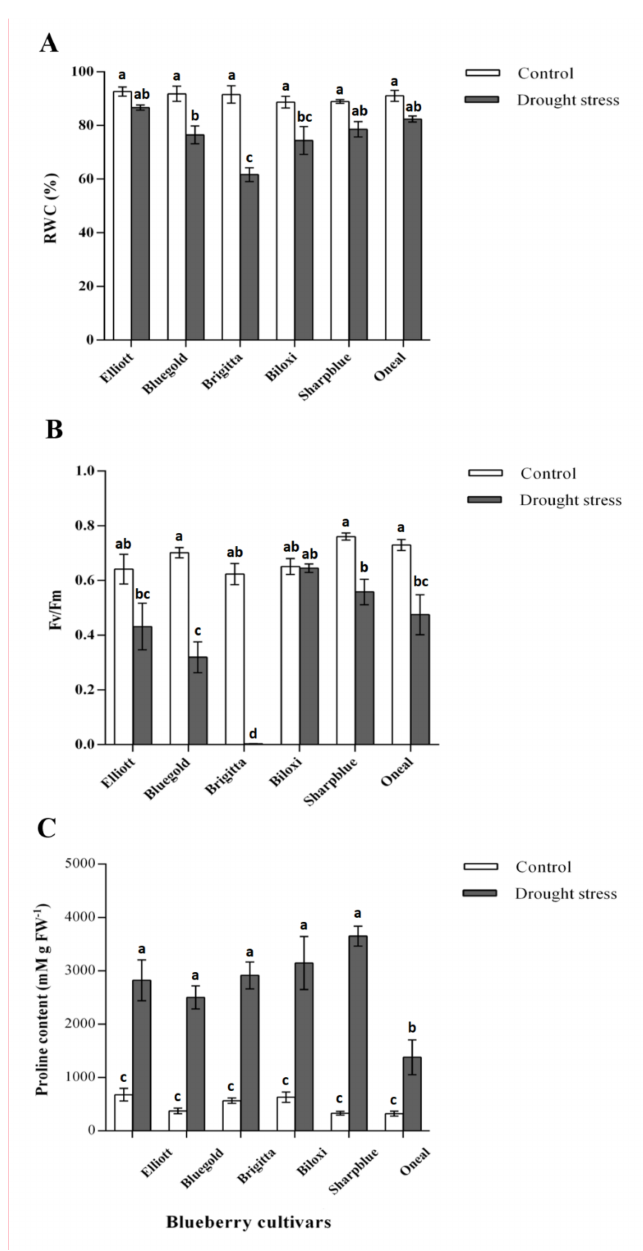
Figure 1. Measurements of physiological parameters after 6 weeks of drought stress. ( A ) Relative